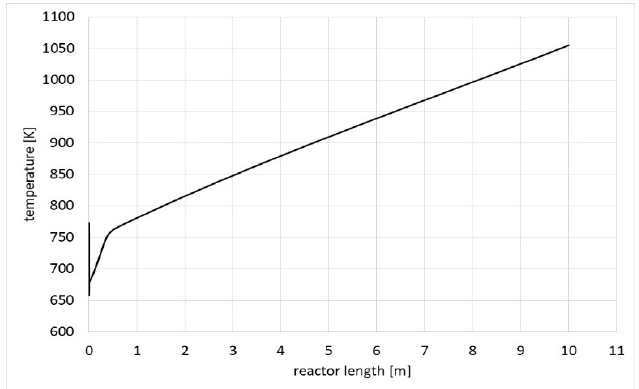
Figure 11. Temperature profile along the length of the reformer tubes at given process conditions.